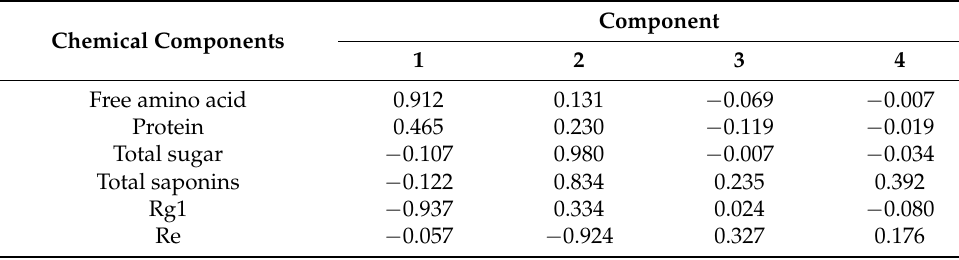
Table 4. PCA of the chemical components of ginseng extracts of different